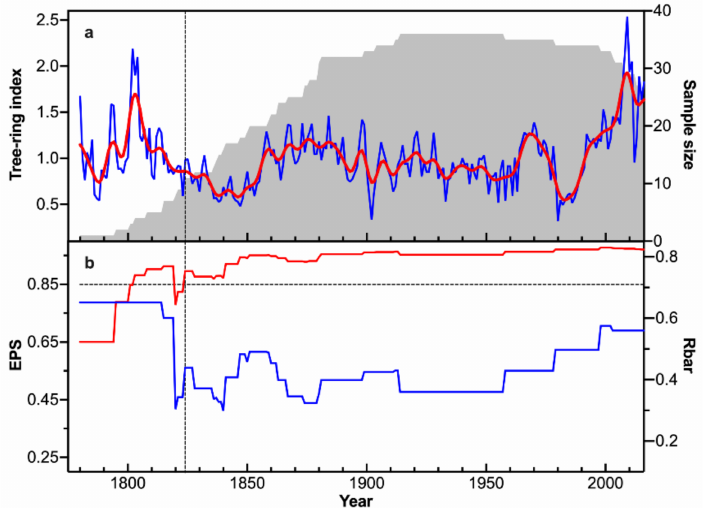
Figure 3. ( a ) TRW chronology at the MRS site in the north-central Pearl River basin (blue line), the 11-year lowpass FFT filter (red line), and the corresponding sample size (gray shading), and ( b ) the running EPS (red) and Rbar (blue) statistics calculated with a 31-year window. Horizontal dashed line in ( b ) denotes the 0.85 cutoff value. Vertical dashed line indicates the beginning year when the EPS value is above